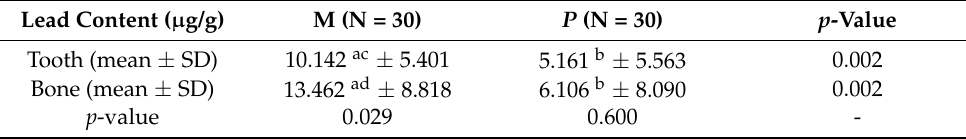
Table 6. Lead content in tested samples taken from patients differing in place of